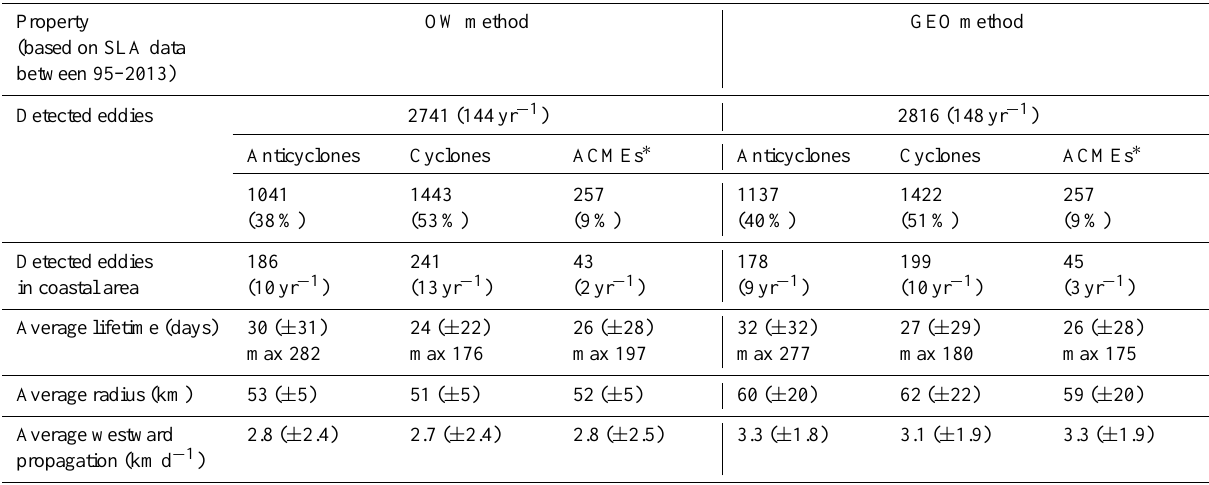
Table 2. Mean properties of anticyclones, cyclones, and ACMEs in the region of 12–22 ◦ N, 16–26 ◦ W (TANWA) and their standard deviation given in brackets, detected from the OW method and the GEO method (detectable longer than 1 week and with a radius >45km). Coastal area is defined as an ∼ 250km wide corridor near the coast (see Fig.